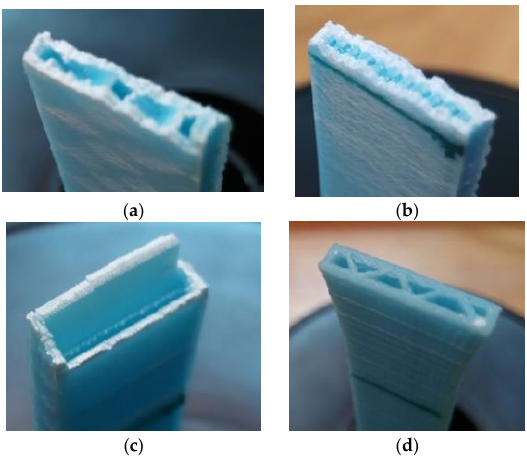
Figure 10. The fracture cross-section. ( a ) Case 1; ( b ) Case 3; ( c ) Case 4; ( d ) Case 5.